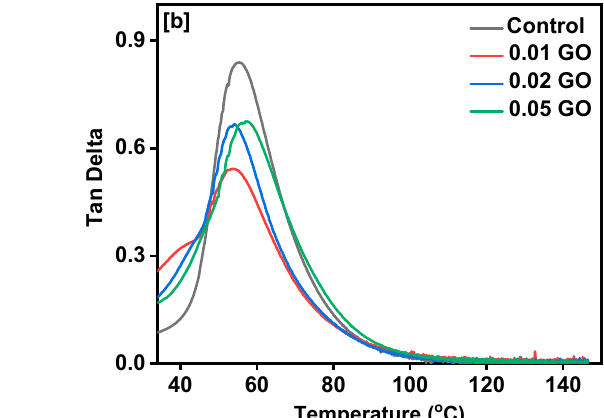
Figure 8. Dynamic mechanical properties of rGO-based films as a function of temperature: ( a ) stor- age modulus and ( b ) tan delta. The DSC test was performed using a DSC Q100 from TA Instruments, and the DSC graphs are presented in Figure 9. The samples demonstrated a region for the Tg that was around 50 °C. This transition matches the results observed in the DMA. Furthermore, there was no melting temperature observed, as a further increase in temperature above 250 °C would lead to the degradation of the film, as observed in the TGA data. Based on this thermal response, it was notable that the film presented a predominantly amorphous phase, which is also in accordance with the information provided by the XRD. Following